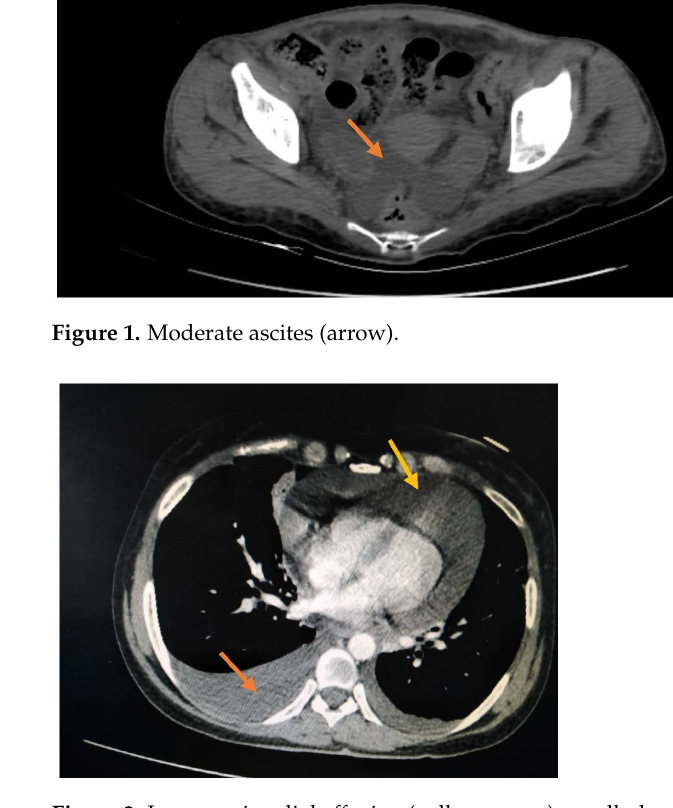
Figure 2. Large pericardial effusion (yellow arrow), small pleural effusion (red arrow). Therefore, pericardiocentesis was emergently performed, and the pericardial fluid contained a leukocyte count of 1500, a lymphocyte percentage of 70%, a protein level of 4 g/dL, and an LDH level of 2519; in the bacterial culture, the tuberculosis PCR was negative, and cytology for malignancy was negative. The patient was admitted to the coronary care unit, and additional investigations were performed to exclude infectious and malignant diseases. The COVID-19 PCR was negative, and the breast mammography and bone biopsy were normal. The laboratory tests are presented in Table 1. Three days after